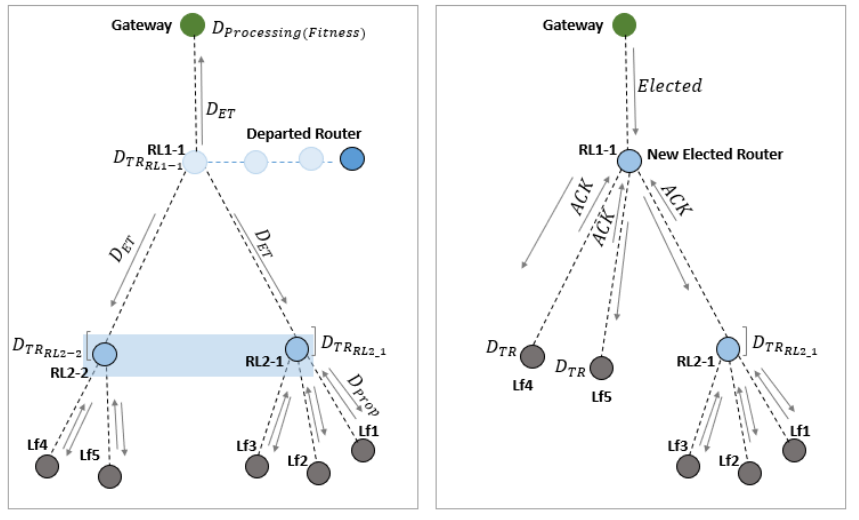
Figure 5. Self-healing phase latency modeling.